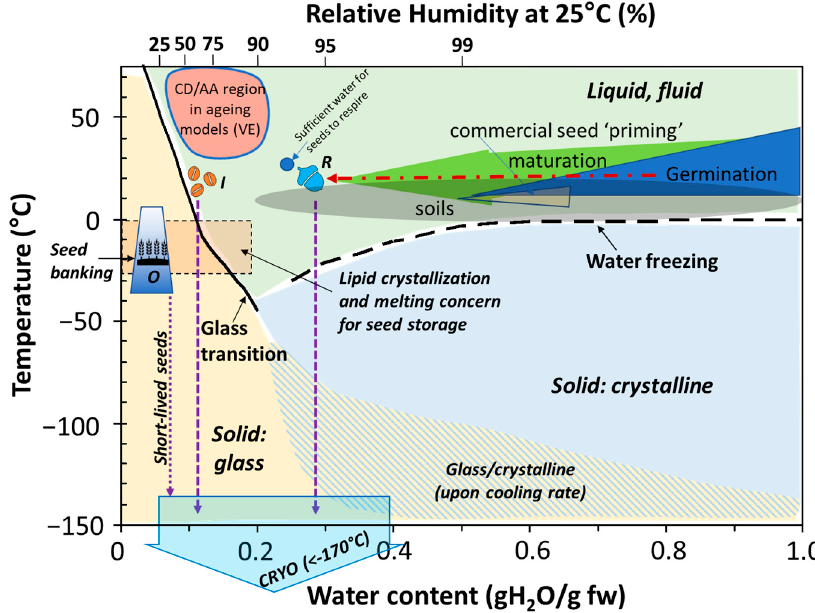
Figure 1. Phase diagram of seed physical states and storage challenges for the different seed storage behaviours. FW: fresh weight; O: orthodox; R: recalcitrant; I: intermediate. CD: control deterioration; AA: accelerated ageing; VE: viability equations; purple arrow: cooling to cryogenic temperatures needed for long-term preservation; red arrow: partial desiccation needed to assure optimal cryopreservation.